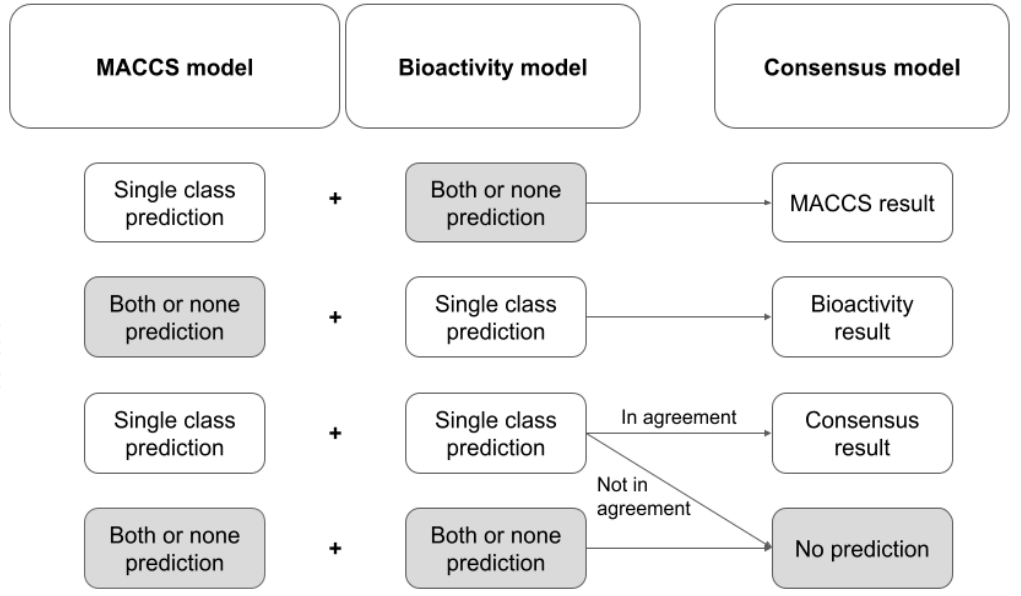
Figure 5. Architecture of the consensus model.